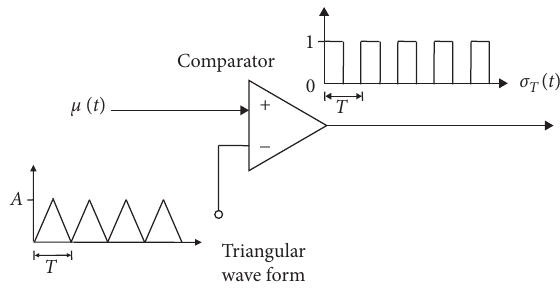
Figure 3: Producing pulse using